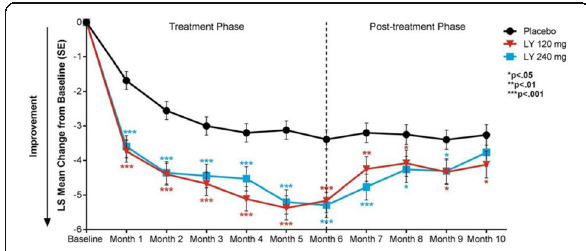
Fig. 1 (abstract P19). Change from baseline in the number of monthly migraine headache days during 6 months treatment and 4 month post-treatment period for EVOLVE-1